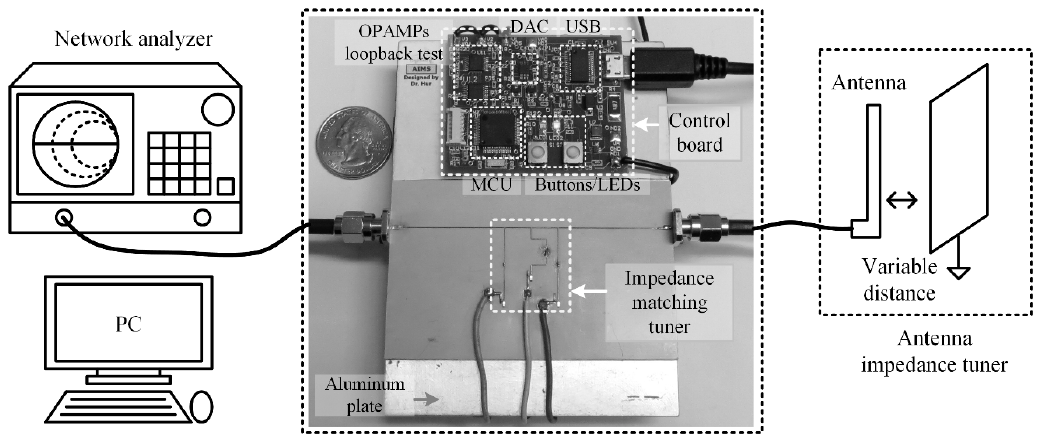
Figure 3. A testing and validation system configuration of the AIMS.